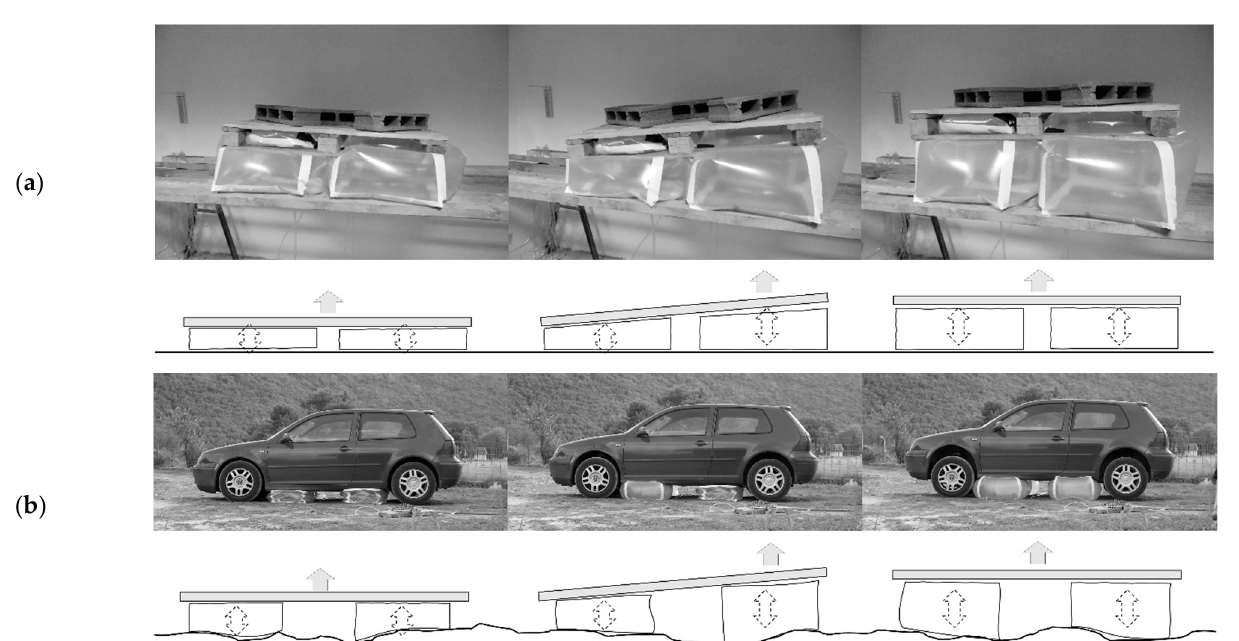
Figure 4. Tests carried out on the type A basic body plan: ( a ) Wooden platform with concrete blocks; ( b ) Lifting a car.